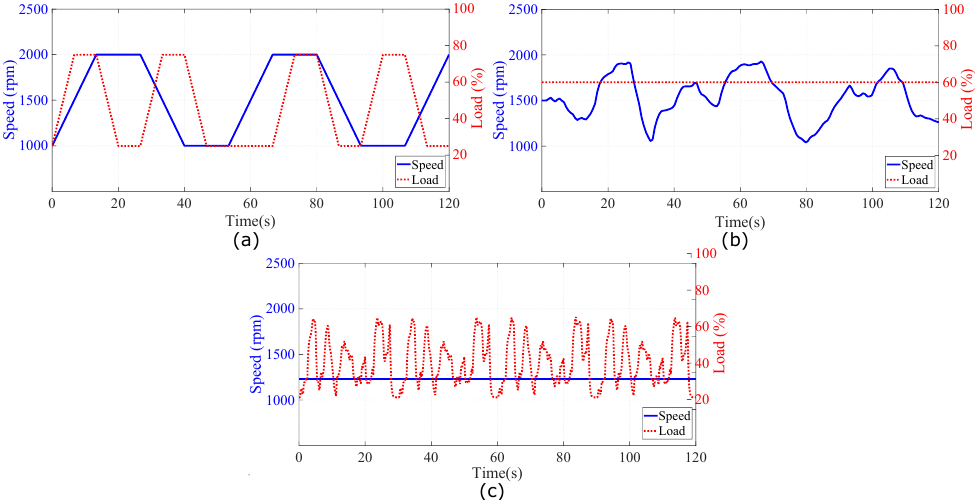
Figure 10. Visual representation of the three operation profiles: ( a ) Profile 1—Variable load and variable speed. ( b ) Profile 2—Constant load and variable speed and ( c ) Profile 3—Variable load and constant